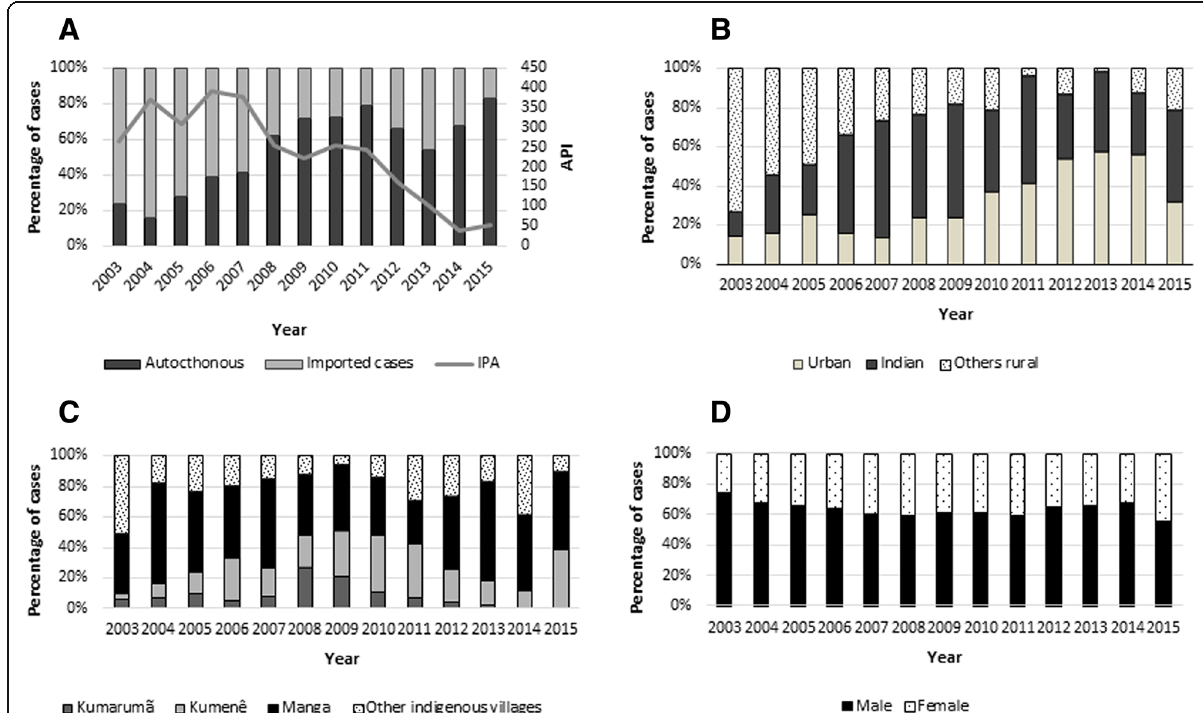
Fig. 1 a . Distribution of imported and autochthonous cases between 2003 and 2015 and API during the study period. b . Distribution of urban, indigenous and other rural cases during the study period. c . Distribution of indigenous cases by base poles and other villages. d . Proportion of malaria cases between men and women between 2003 and